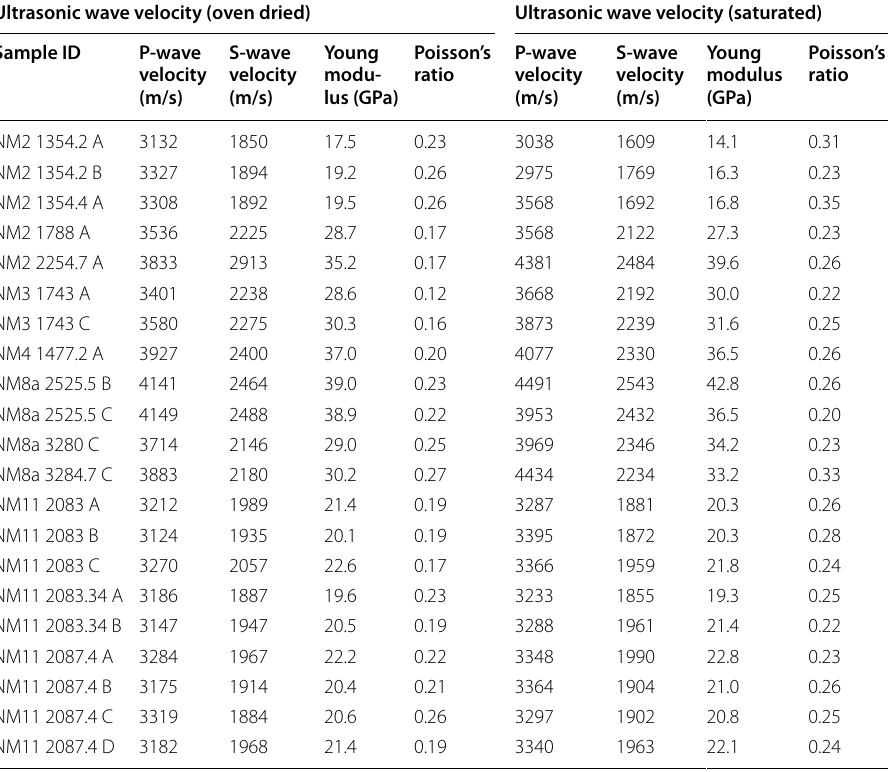
Table 6 Ultrasonic wave velocities and the derived dynamic elastic constants; oven dried and saturated